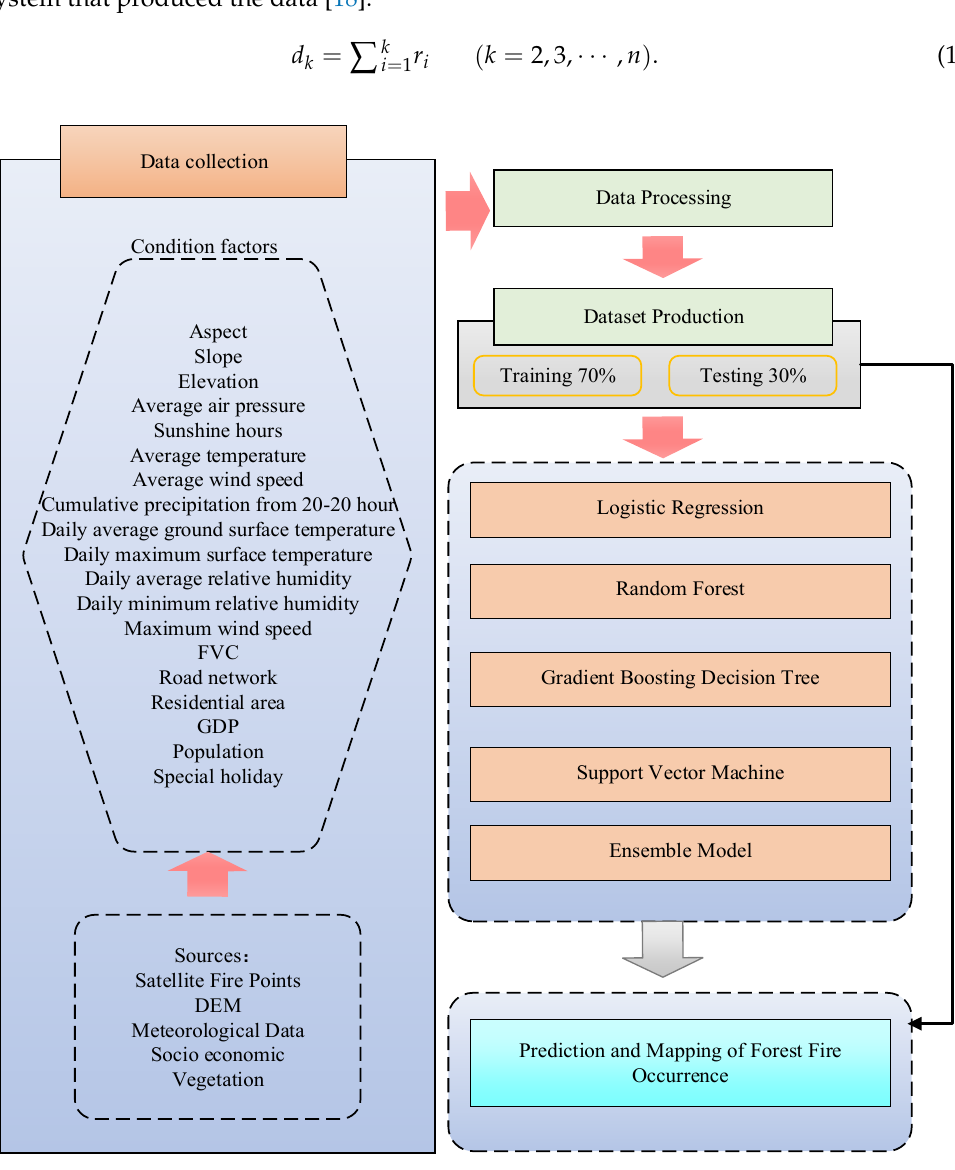
Figure 2. Technology